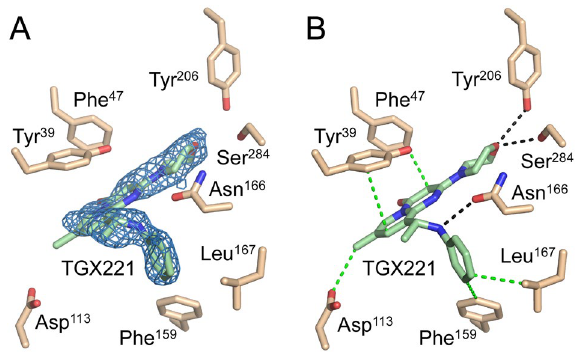
Figure 6. EgtD-TGX221 interactions. ( A ) The 2Fo-Fc omit map of the TGX221 ligand contoured at 1.0 σ. ( B ) The van der Waals interactions and polar interactions between the ligand and protein are shown in green and black,